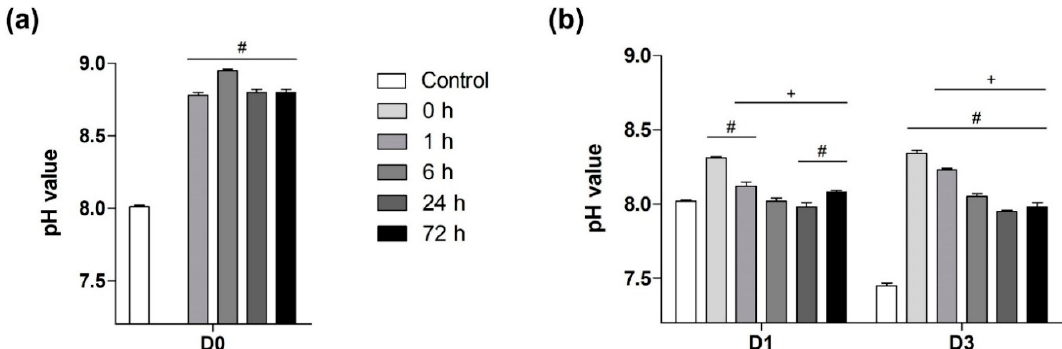
Figure 3. Evaluation of pH values. ( a ) pH values of the media used for preconditioning of the BG after 1, 6, 24, and 72 h in comparison to pure DMEM serving as control. Due to the missing passivation period, no pH values were obtained for the 0 h group since the BGs were directly introduced to the CCM without passivation. ( b ) pH values of all groups after 1 and 3 days in CCM. Values are displayed as means with standard deviation. Significant differences to the control group are indicated by (#), while (+) shows significant deviation to the non-passivated BG group.